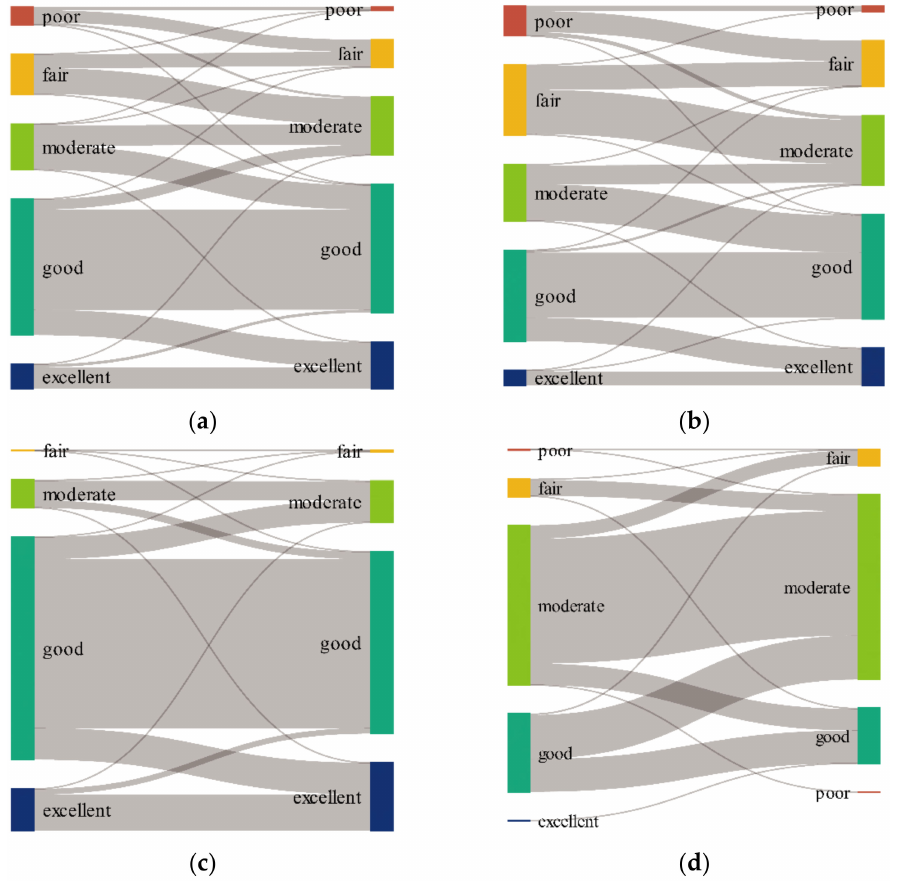
Figure 6. Area transitions (km 2 ) of various levels from 2001 to 2020 in ( a ) LHRB, ( b ) upper reaches, ( c ) middle reaches, ( d ) lower